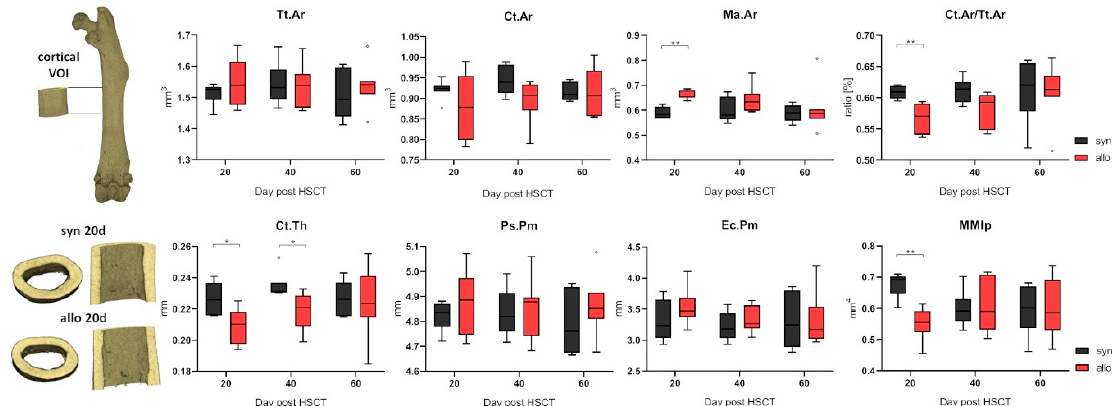
Figure 3. Cortical bone structure was analyzed in the midshaft of the femora (cortical VOI as indicated above left; allo N = 6, syn N = 7). While the periosteal perimeter (Ps.Pm) and the total area (Tt.Ar) of the bone remained unchanged, the cortical thickness (Ct.Th) diminished in allo-HSCT recipients. The cortical thinning was caused by a significantly larger medullary area (Ma.Ar) and the significantly lower ratio of total and cortical area (Ct.Ar/Tt.Ar), however the endocortical perimeter (Ec.Pm) was only slightly increased. The polar moment of inertia (MMIp) was decreased due to the thinner cortical bone in allo-HSCT recipients. * p ≤ 0.05; ** p ≤ 0.01 by Mann-Whitney-U-Test.